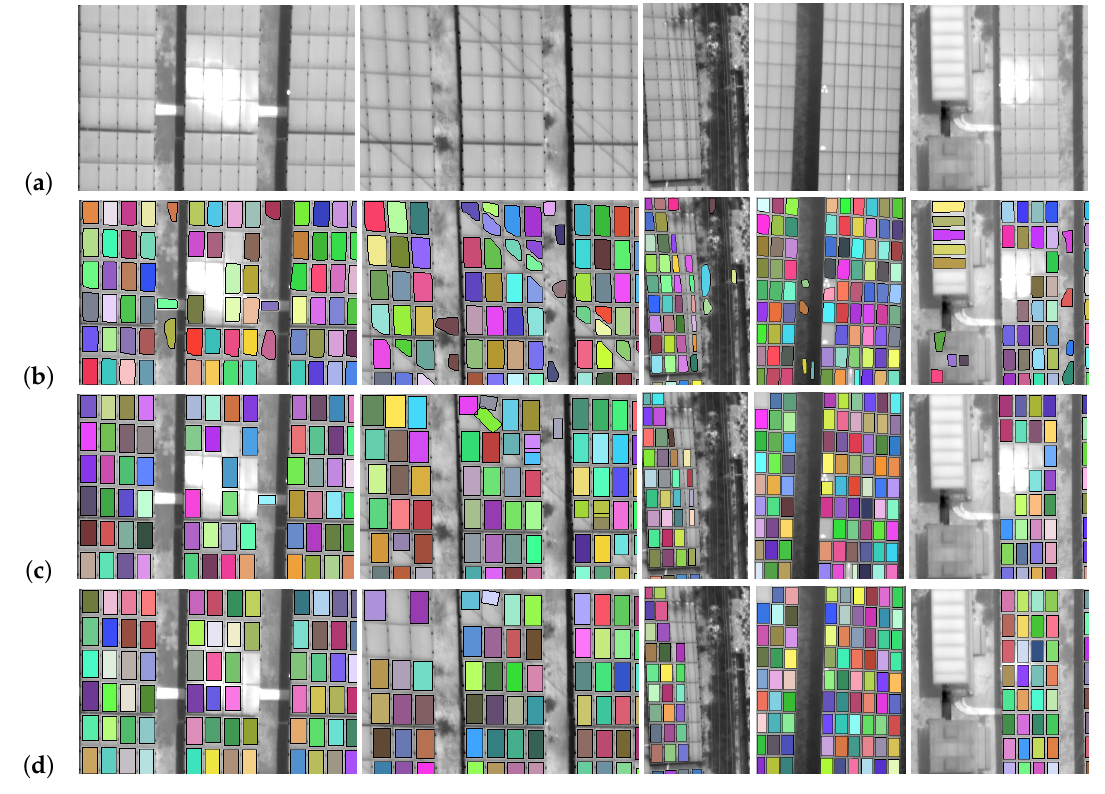
Figure 9. Detection of panels in thermal images with a novel method based on classical techniques and a post-processing step. Different cases of true positives, false positives and false negatives: ( a ) Thermal image in gray scale, ( b ) classification by classical segmentation with classical method, ( c ) classification with a support vector machine and ( d ) classification after